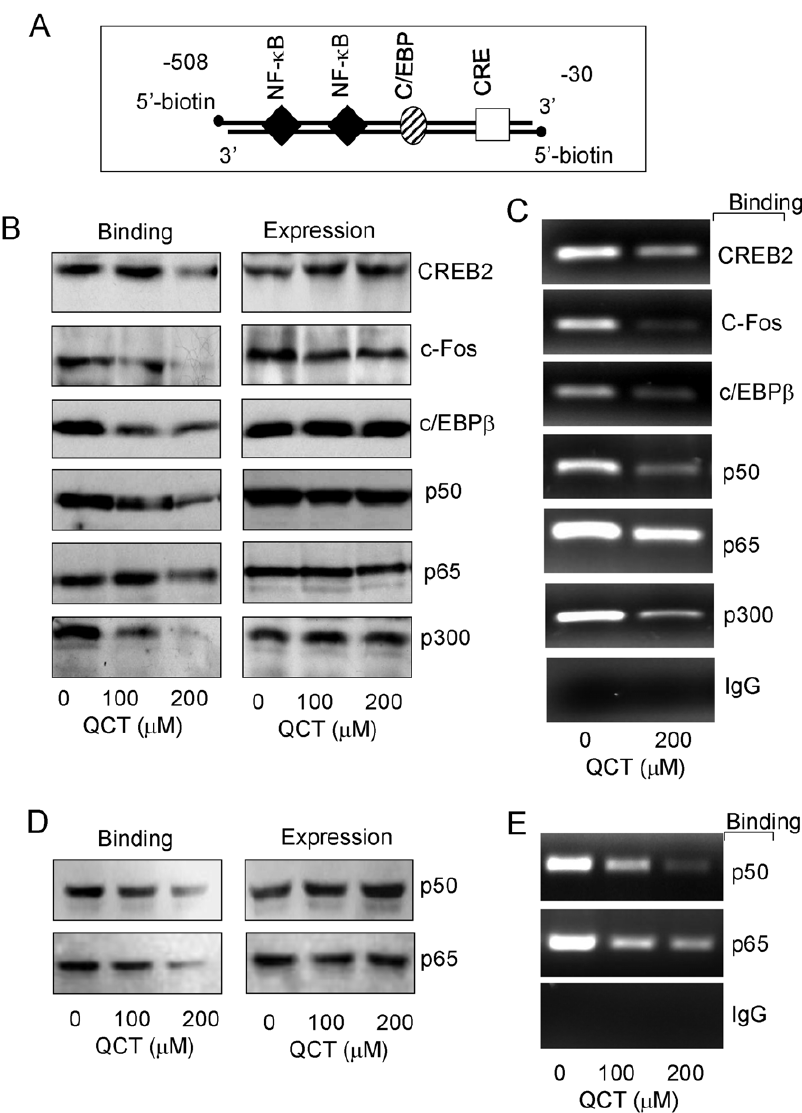
Figure 4. Quercetin inhibited binding of multiple transactivators and p300 to COX-2 promoter. Human MDA-MB-231 and MCF7 cells were treated with quercetin for 48 h. The binding of transactivators and p300 to COX-2 promoter was analyzed by streptavidin-agrose pulldown assay or ChIP assay. A biotin-labeled COX-2 promoter probe ( A ) which harbors all the indicated transactivators was used. Nuclear proteins in MDA- MB-231 ( B ) and MCF7 ( D ) cells were incubated with the COX-2 probe and streptavidin-agrose beads. After centrifugation, proteins in the complex were detected by immunoblots ( B , D ). Chromatin in MDA-MB-231 ( C ) and MCF7 ( E ) cells was immunoprecipitated with antibodies to the indicated transactivators and the COX-2 promoter region in the precipitated chromatin was amplified by PCR. The non-immuno IgG was used as negative control. The figures are representative of three experiments. IgG, non-immuno IgG.